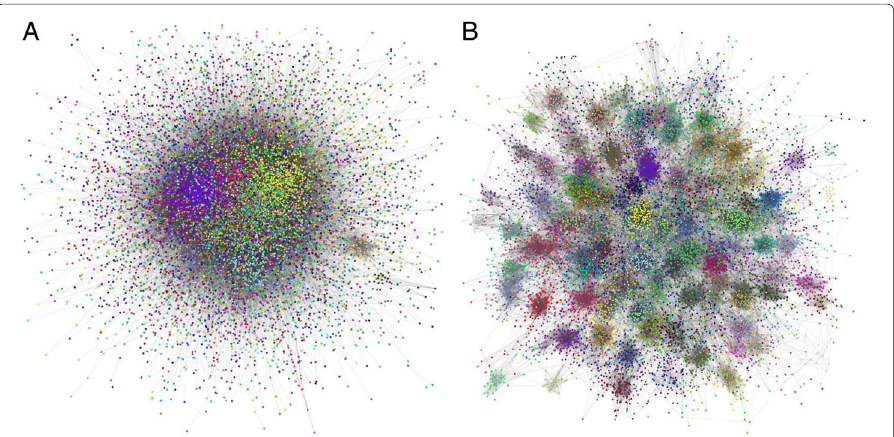
Fig. 2 Regulatory networks corresponding to the control a and tumor b phenotypes. Nodes are colored according to the module to which each node belongs. Notice that in B, a visible modular structure appears, reinforced by the distribution of colors, meanwhile in A the network link distribution looks more